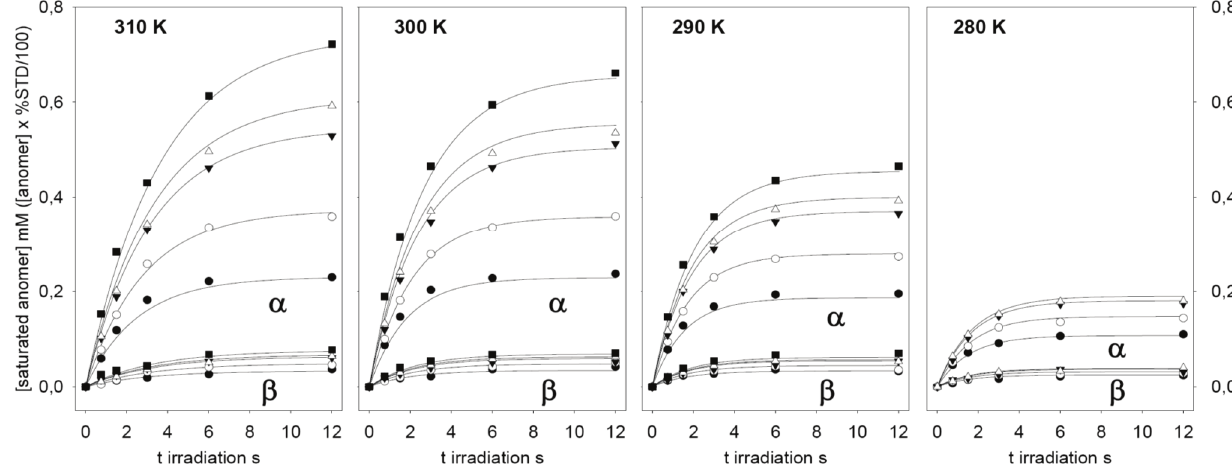
Figure 4. Time-dependent build-up curves of ligand saturation, expressed in mM, obtained for (cid:3)-2FDM (upper lines) and (cid:5)-2FDM (lower lines) in the presence of ConA (90 μM). Five different total concentrations of 2FDM, i.e ., 0.96 ((cid:8)); 1.94 ((cid:9)); 4.14 ((cid:10)); 5.57 ((cid:11)); and 12.1 mM ((cid:12)), were studied from 0 to 12 s irradiation time and at four temperatures. The solid lines correspond to calculated curves for each 2FDM concentration obtained from the global fitting of the experimental data at each temperature to the kinetic model (see Methods and text) with DynaFit [51] (data for the highest concentration of 2FDM at 280K was excluded from the fitting). Values derived from the fitting for the dissociation constants are in Table